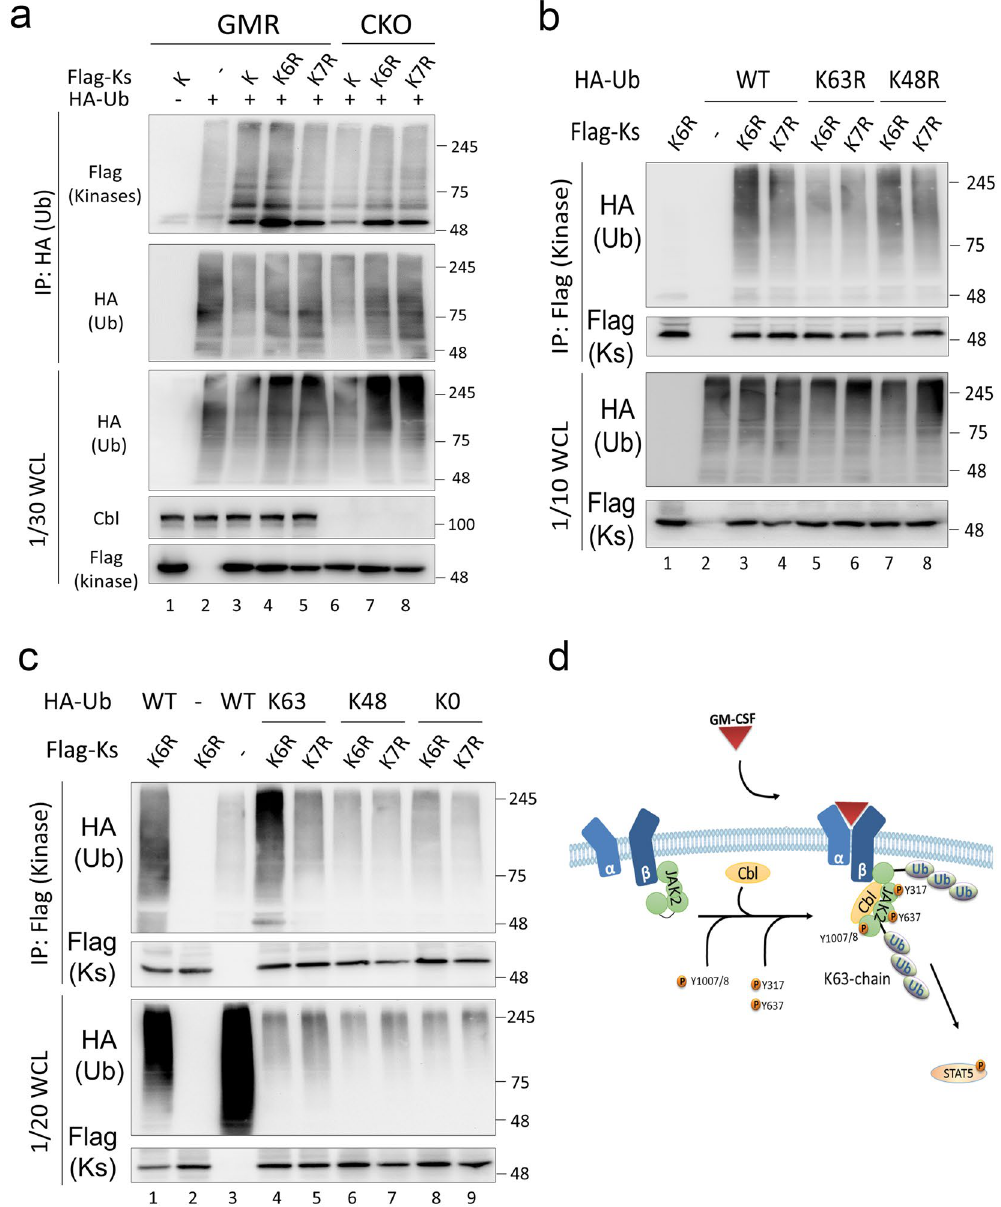
Figure 8. K63-linked poly-ubiquitination of JAK2 K970 is promoted by Cbl. ( a ) The ubiquitination of JAK2 K970 is decreased in absence of Cbl. Flag-tagged JAK2 kinase domain mutants (as described in Fig. 7c) and HA-tagged ubiquitin were co-expressed in GMR cells and CKO cells as described. WCLs were prepared and analysed as described in Fig. 1. ( b ) The ubiquitin K63R substitution greatly reduces the ubiquitination ability of JAK2 K970. JKO cells were co-transfected with Flag-tagged JAK2 kinase domain mutants (K6R and K7R) and HA-tagged WT, K63R, or K48R ubiquitin mutants. Transfected cells were treated with MG132 (10 μ M) for 4 h before harvest. WCLs were prepared and analysed as described in Fig. 1c. ( c ) The K63-only mutant partially rescues ubiquitination on JAK2 K970. JKO cells were co-transfected with Flag-tagged JAK2 kinase mutants (K6R or K7R) and HA-tagged WT or K63-only (K63), K48-only (K48), or the no-Lys (K0) mutant. Cells were processed and analysed as described above. ( d ) A schematic model for Cbl-mediated JAK2 K63-linked poly- ubiquitination and activation upon GM-CSF stimulation based on research data presented in this